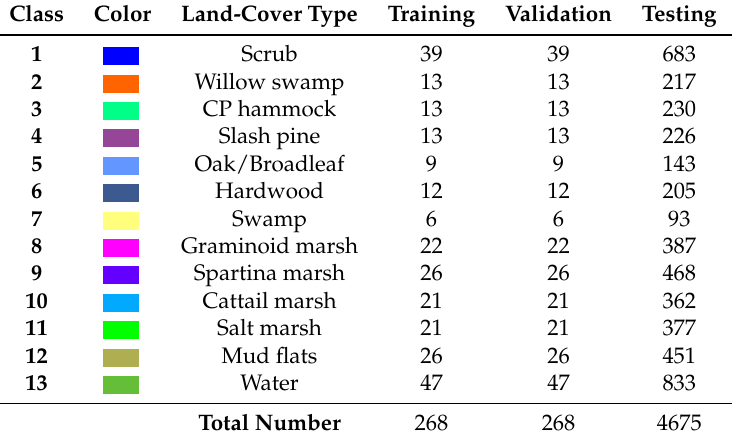
Table 5. Number of samples of the Kennedy Space Center (KSC)